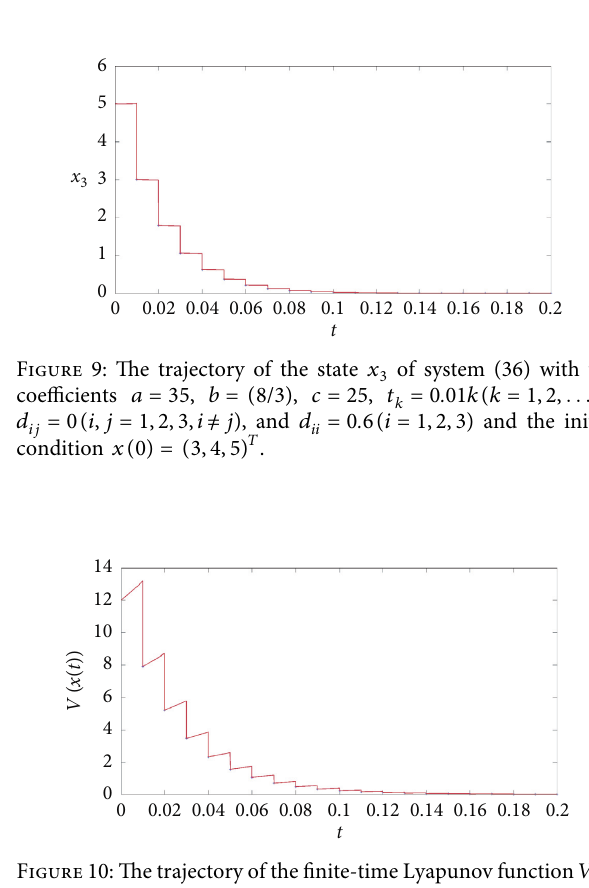
� 0 ( i,j � 1 , 2 , 3 ,i ≠ j ) , and d ij